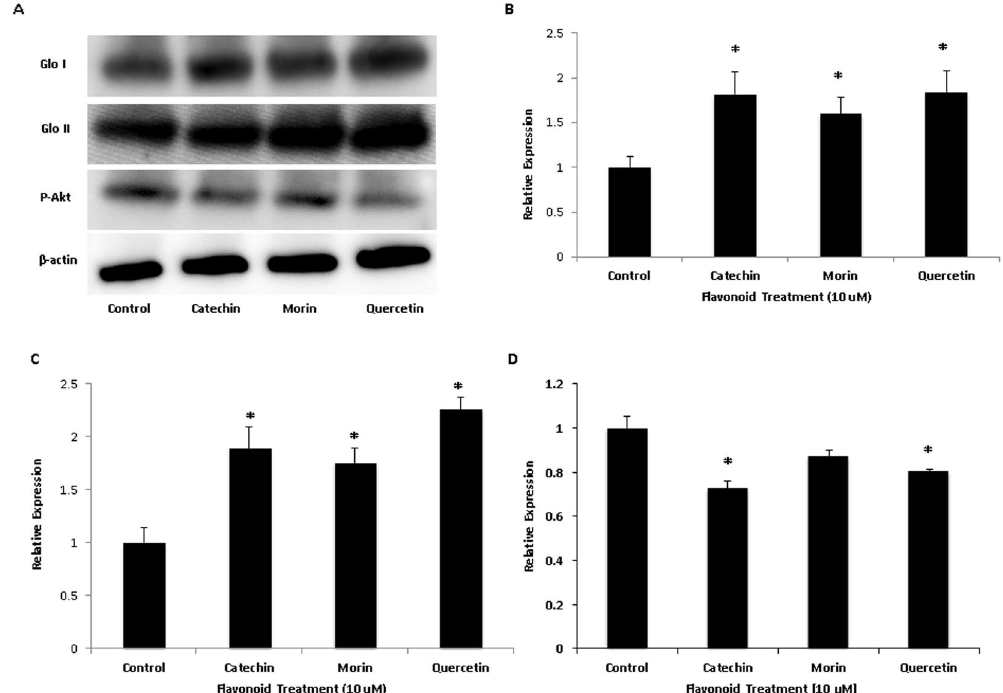
Figure 5. Effect of flavonoid treatment on expression of proteins glo-1 ( B ), glo-2 ( C ), and pAkt ( D ). Representative Western Blot images ( A ). Values are means + / − SEM of samples performed in triplicate from several independent experiments, n = 3–4. * P < 0.05 (vs Control). Expression of P-Akt in cerebellar neurons was assessed via Western Blotting. Cerebellar neurons were treated with MG (500 μ M) and flavonoids (10 µ M). Blots were conjugated with β -actin to ensure equal protein loading. Control = only MG. Values were determined using ImageJ. Resulting data were analyzed using an ANOVA. A significant decrease ( * p < 0.05) in P-Akt was found in the catechin and quercetin treated groups (10 μ M) compared to the MG treated